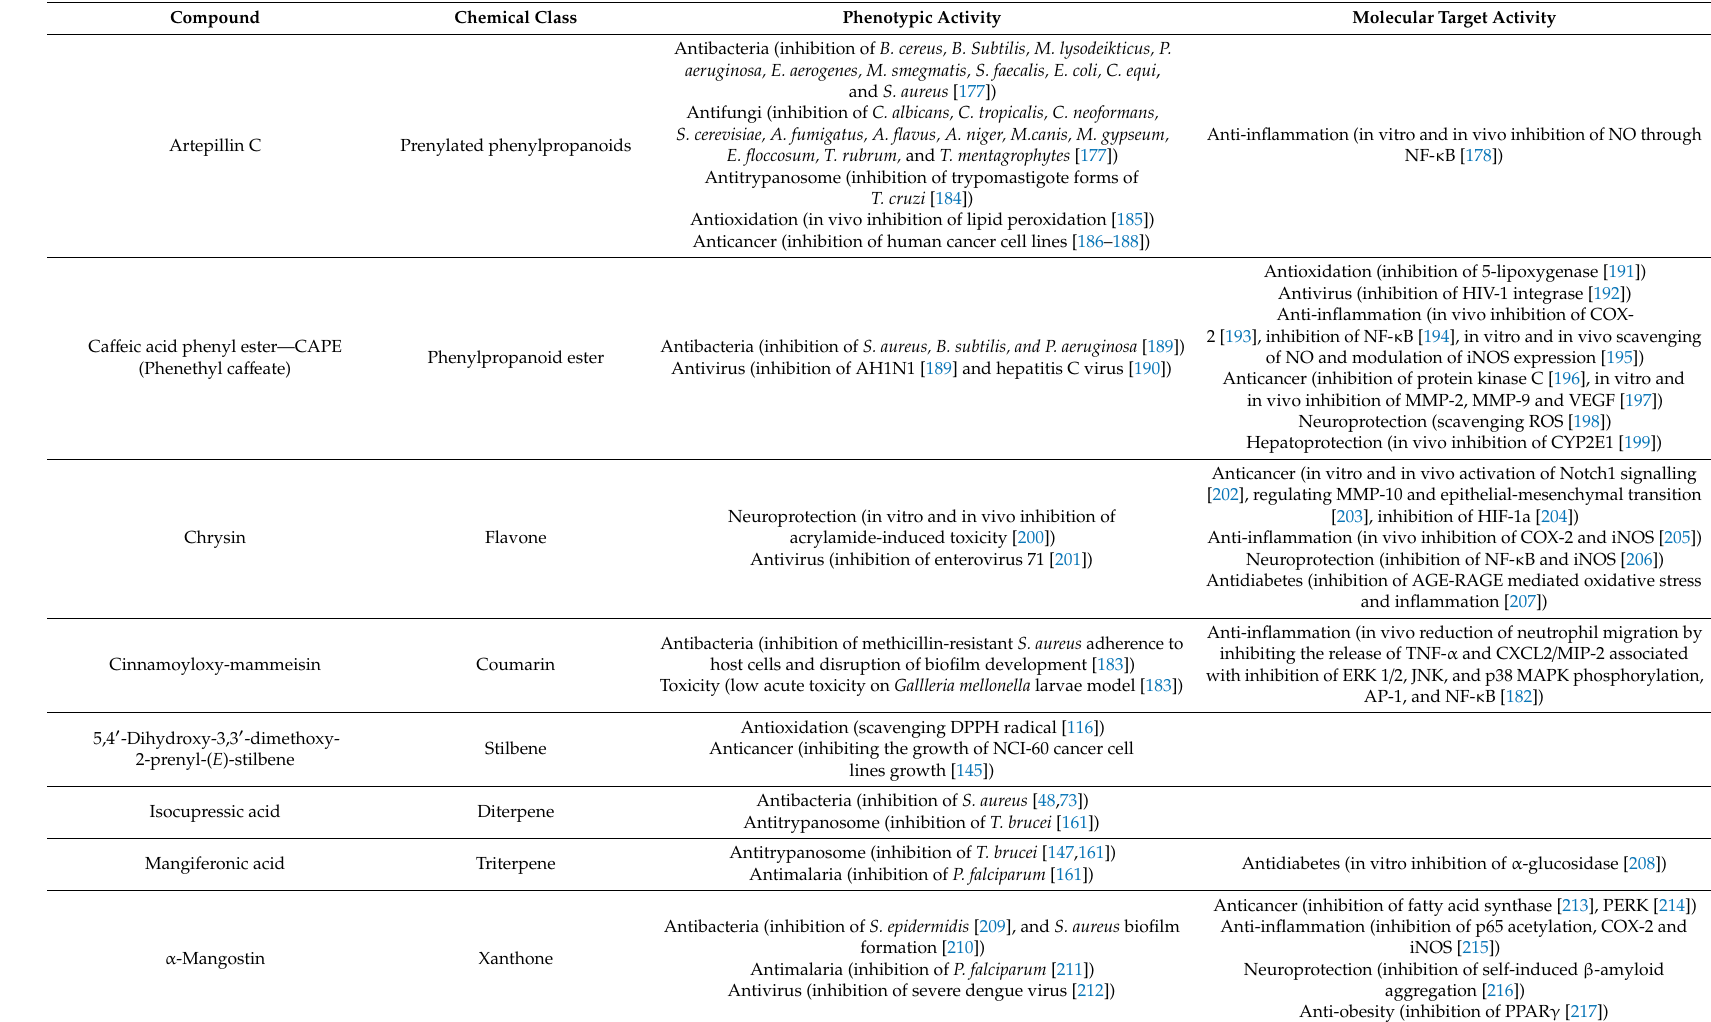
Table 2. Representative compounds in propolis with known biological